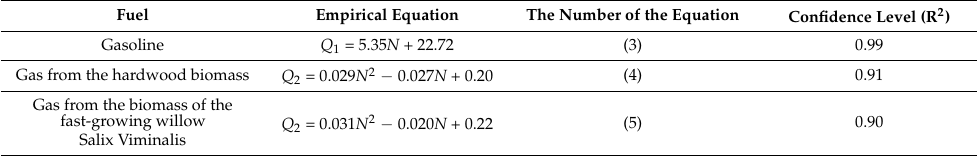
Figure 10. Emissions of CxHy.